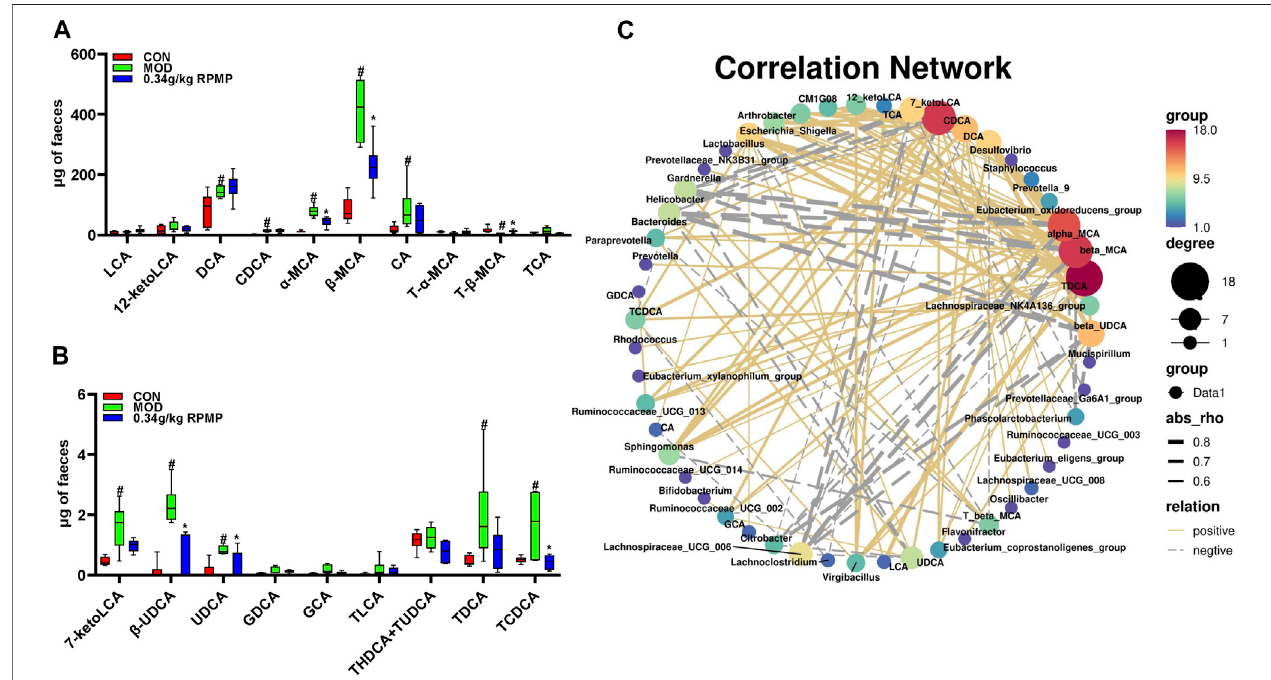
FIGURE 10 | Structural components of BAs pool. (A,B) Effect of RPMP ethanol extract on BAs species. (C) Correlation network diagram of IM species with BAs. The data were presented as the means ± SEM, # p < 0.05, compared with the CON group; * p < 0.05, compared with the MOD group ( n (cid:2) 6).